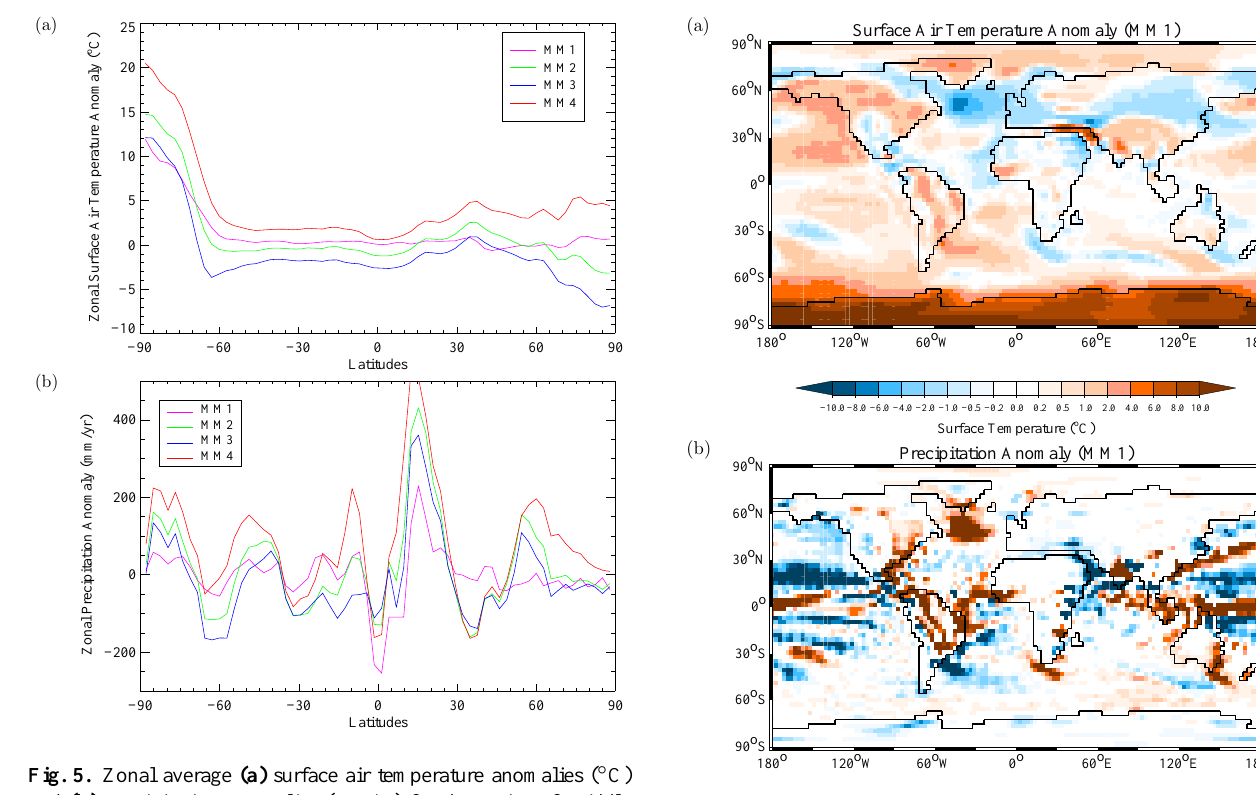
Fig. 5. Zonal average (a) surface air temperature anomalies ( ◦ C) and (b) precipitation anomalies (mm/yr) for the series of Middle Miocene simulation experiments MM1 to MM4.